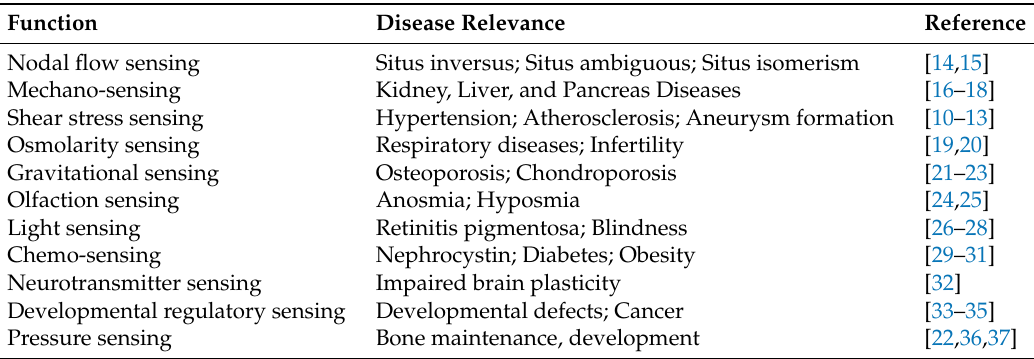
Table 1. Ciliary function and disease